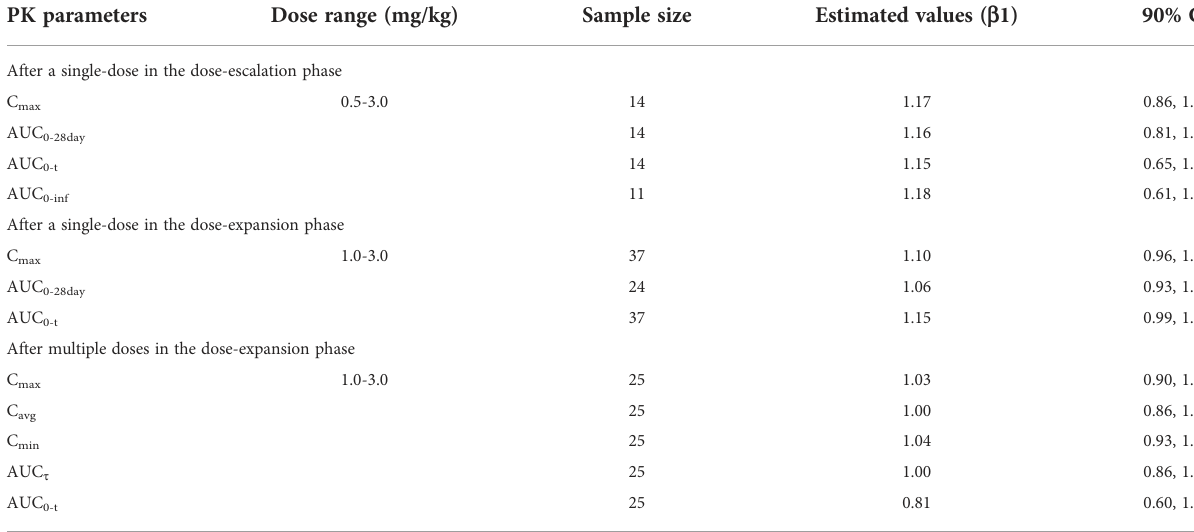
TABLE 5 Dose proportionality assessment of